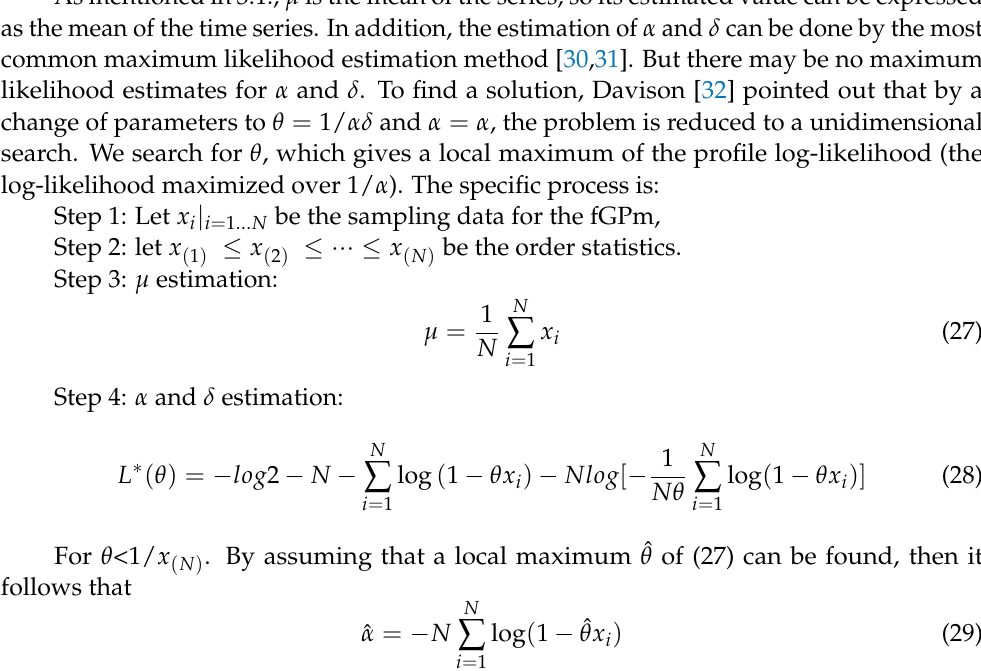
Figure 10. fGPm sequences generated with α = 1.5 , µ = 0.4586, δ = 0.0396 , H = 0.75 , X 0 = 0.6, by the Monte Carlo simulation method.